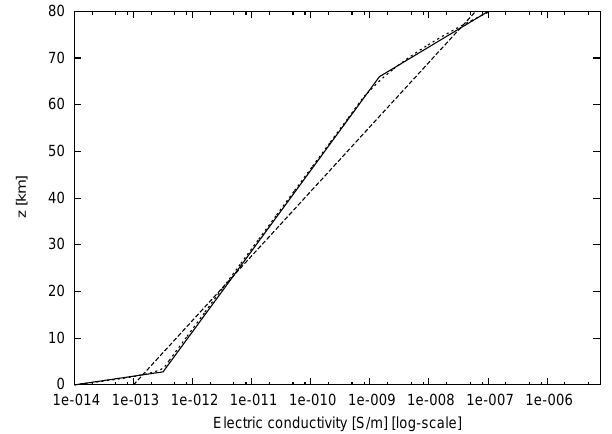
Fig. 1. Conductivity profile of the atmosphere up to an altitude of 80km. The curves indicate the actual three-layer model (solid line), the model of Denisenko et al. (2008) (dashed line), and the em- pirical model reported by Molchanov and Hayakawa (2008) (dotted line).